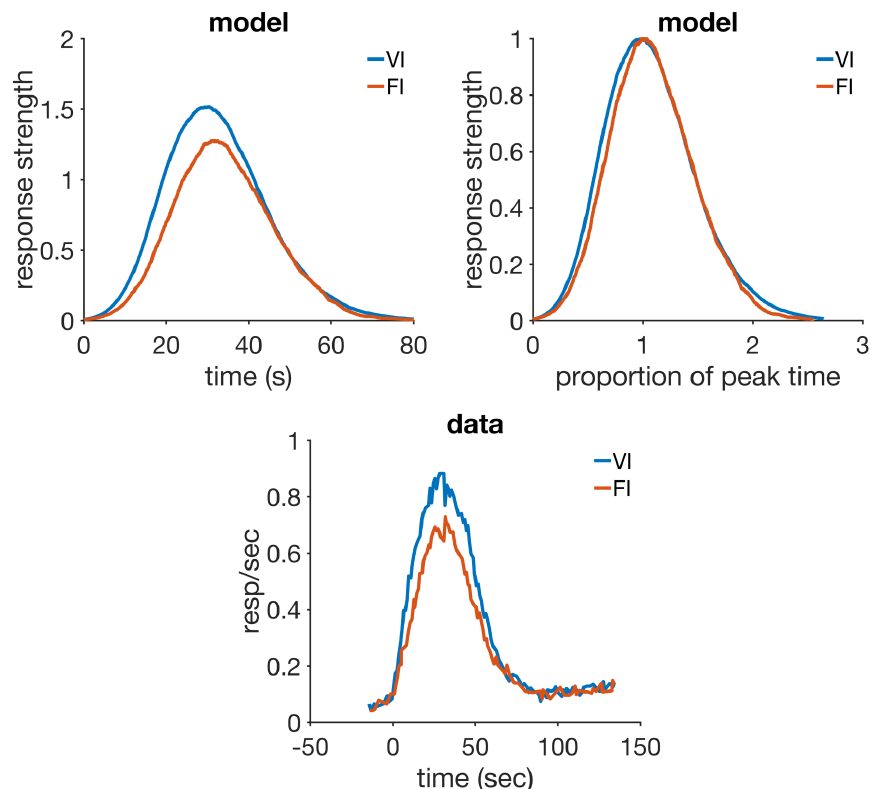
Fig 13. VI and FI. Top row: simulatedaverageresponsestrength duringpeak trials (left), and the same data plotted after both axes are normalized(right). Bottom row: averageresponsestrength data from an experiment in VI and FI, redrawn from Figure 1 in [108]. Model parameters: α t = 0.1, α V = 0.1, μ = 1, σ = 0.3, m = 0.2, H = 40.